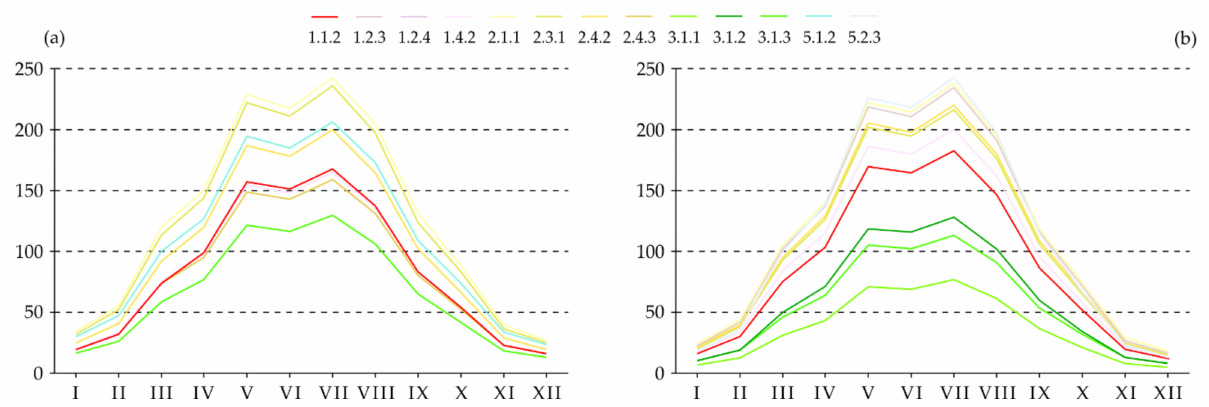
Figure 14. The course of average monthly sums of global solar radiation [in kWh · m − 2 ] for individual types of land cover (CLC) for the Cieplice ( a ) and Kołobrzeg ( b ) health